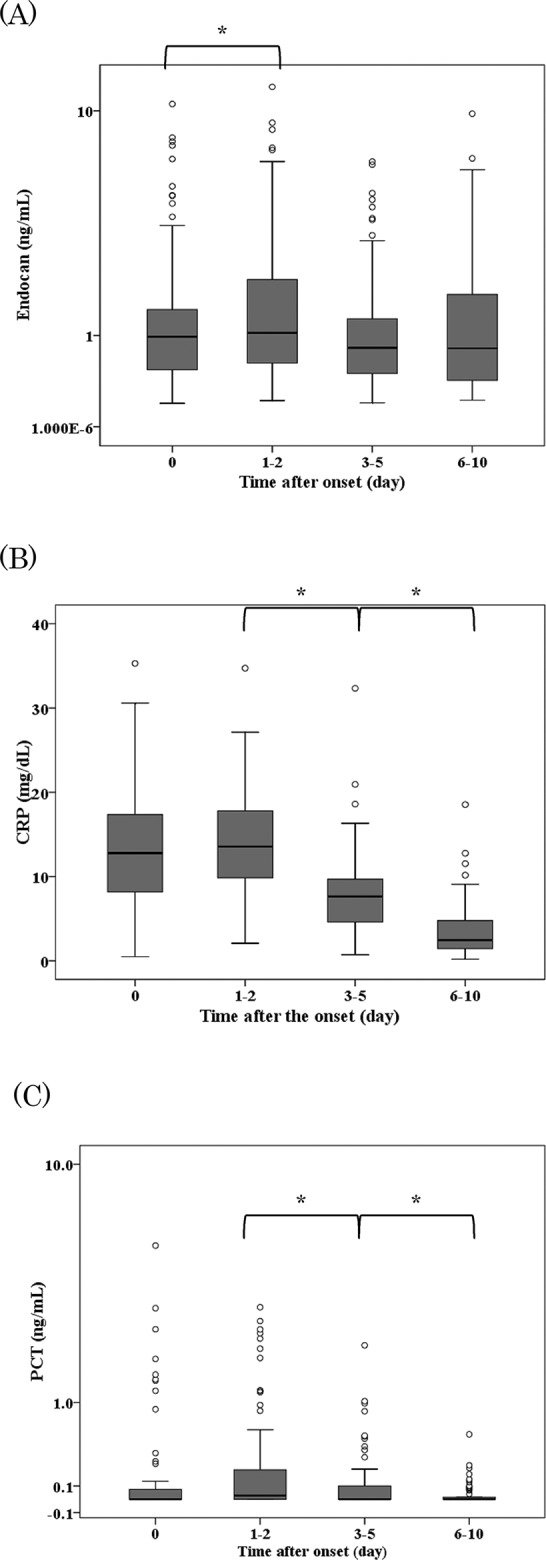
Trends of endocan (A), C-reactive protein (CRP)(B), procalcitonin (PCT)(C) levels in patients during infection.The boxes represent the interquartile range, and the transverse lines in the boxes represent the medians of each group. The vertical lines represent 1.5 of the interquartile range. The circles indicate outliers of each group. The y axes for endocan in (A) and for PCT in (C), but not for CRP in (B) are in log values.* P<0.001.